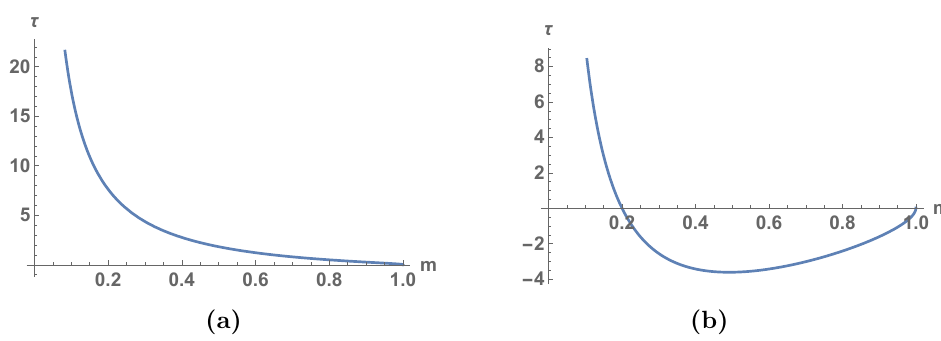
Figure 1 . The relation between the width of the eigenvalue distribution and the coupling (cid:28) for given (cid:21) . In the interval 0 < (cid:21) < 2, (cid:28) ( m ) has the form of (cid:12)gure (b). (a) (cid:21) = 4. (b) (cid:21) =